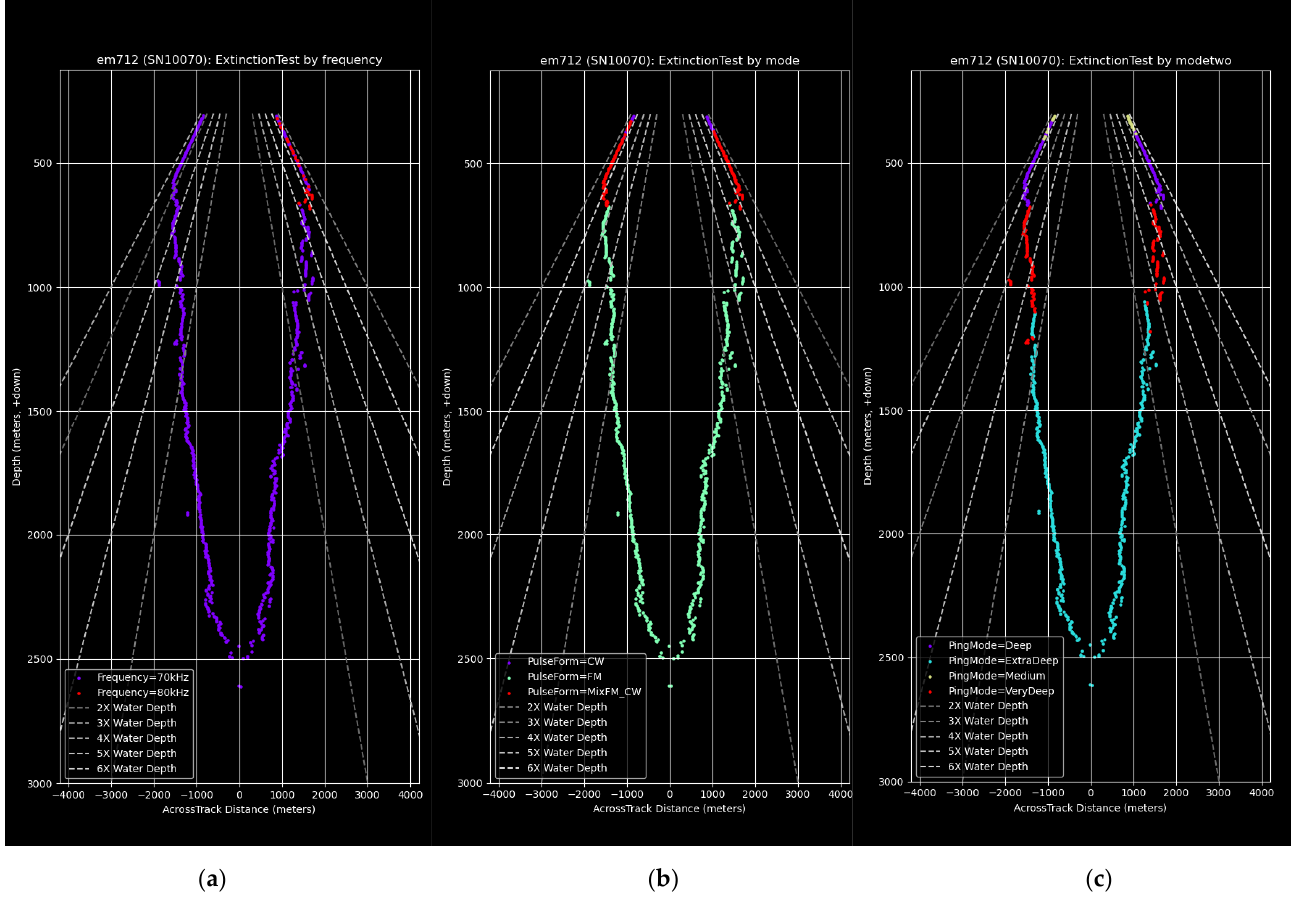
Figure 12. Kluster Extinction Test results for the second test. Illustrates: ( a ) Swath width versus depth colored by frequency; ( b ) Swath width versus depth colored by the first mode value, which is either a Continuous Wave (CW) pulse or a Frequency Modulated (FM) pulse; ( c ) Swath width versus depth colored by the second mode value, which is the Kongsberg Ping Mode.